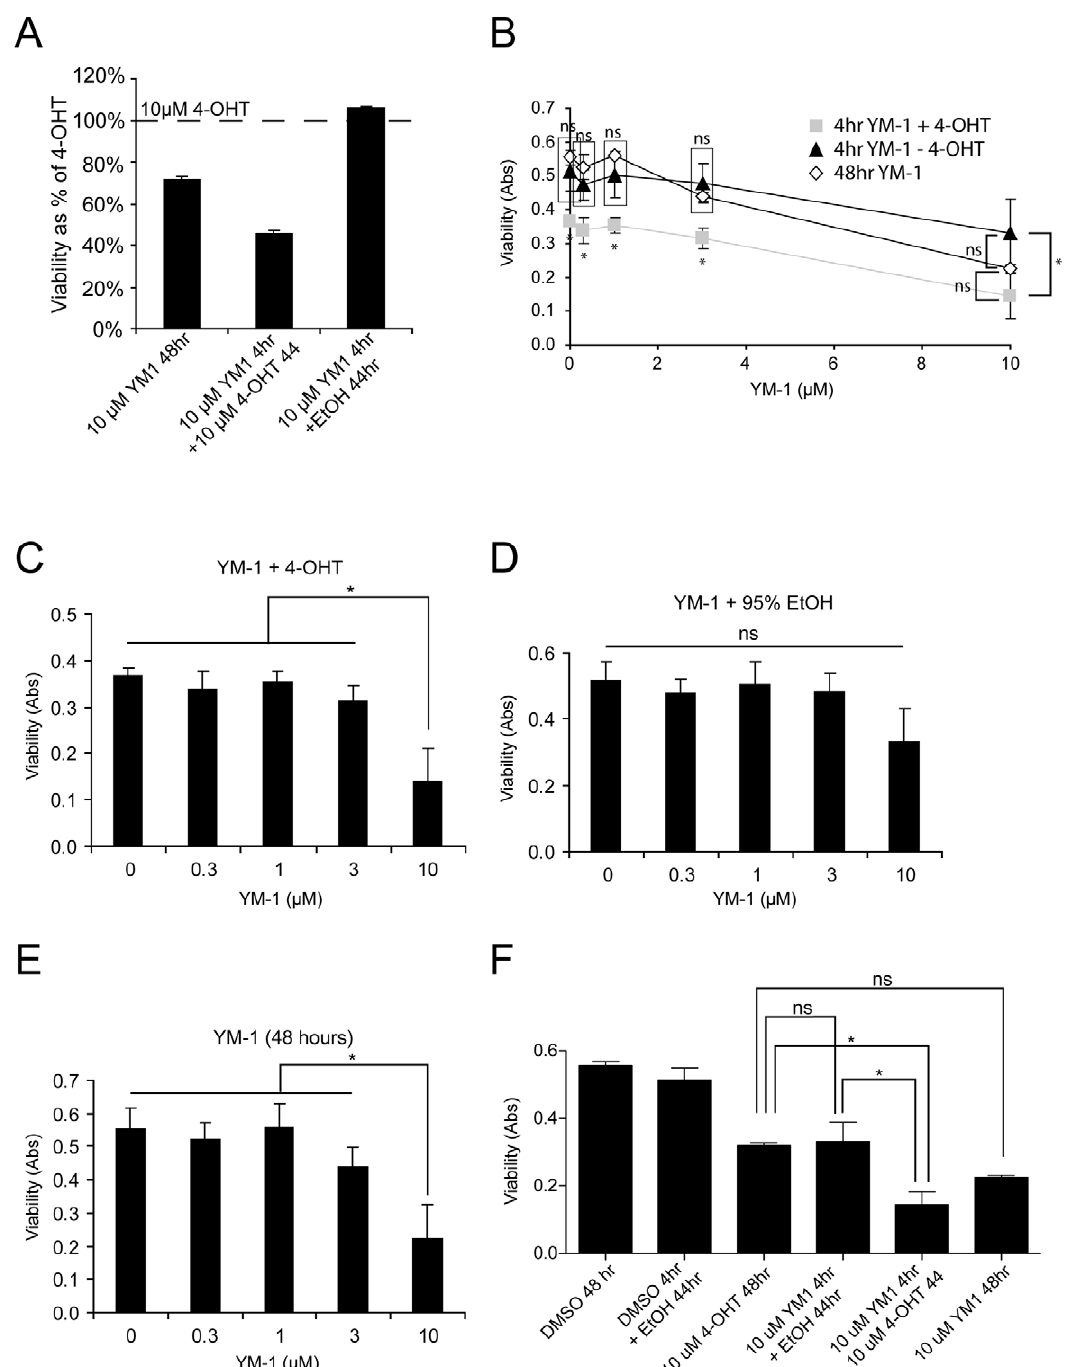
Figure 4. Brief exposure to YM-1 restores tamoxifen effect in resistant cell model. TR-MCF7 cells were treated with 4-OHT for 48 hours, YM-1 (or vehicle) for 4 hours followed by 44 hours of either 4-OHT or 95% EtOH, or YM-1 (or vehicle) for 48 hours. At 48 hours from initial treatment, MTT viability assays were performed. Viability values of each treatment as a % of 48 hours of 4-OHT treatment 6 SD (A). 2-Way ANOVA analysis comparing all YM-1 treatment groups (Gray squares- 4-hour YM-1then 4-OHT, open diamonds- 48 hour YM-1, black triangles- 4-hour YM-1 then 95% EtOH), revealed significance across concentrations (F(2,30)=54.22, p , 0.0001), and treatment strategy (F(4, 30)=41.04, p , 0.0001), but no significant interaction (F(8,30)=1.83, p=0.1107). * - indicates significant difference (p , 0.05) of 4-hour YM-1 then 4-OHT from other two groups with exception of 10 m M treatments, significance as indicated (ns=p . 0.05)(B). 1-way ANOVA of YM-1 + 4-OHT strategy revealing significance of 10 m M concentration (F(4,10)=16.49, p=0.0002)(C). Analysis of YM-1 + 95% EtOH, by 1-way ANOVA, revealed no significance across tested concentrations (F(4,10)=3.435, p=0.0516)(D). 48-hour YM-1 treatment showed significance differences between all concentrations and the 10 m M concentration, by 1-way ANOVA (F(4,10)=12.32, p=0.0007)(E). 1-way ANOVA analysis (F,(5,12)=24.33, p , 0.0001) comparing all 10 m M YM-1 treatments, 48-hour 4-OHT, and vehicle treatments revealed no significant difference between 48-hour 4-OHT and both 4-hour 10 m M YM-1 + 95% EtOH and 48-hour 10 m M YM-1 treatments; whereas the 48-hour 4-OHT and the 4-hour 10 m M YM-1 + 95% EtOH were significantly different from the 4-hour YM-1 + 4-OHT treatment (p , 0.05)(F).